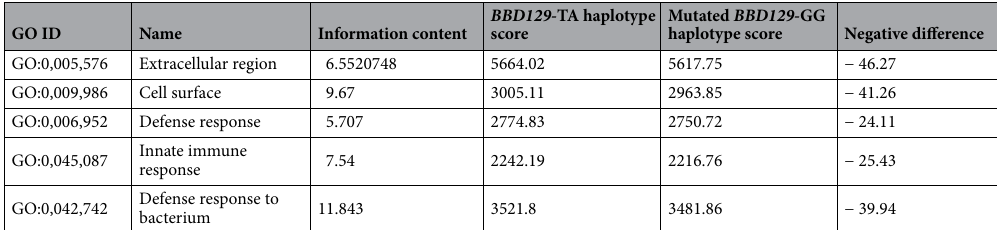
Table 3. The list of biological functions comparison between BBD129 -TA haplotype and mutated BBD129 -GG haplotype proteins. The analysis of possible impacts of amino acid substitutions on BBD129 protein were predicted by Argot 2.5